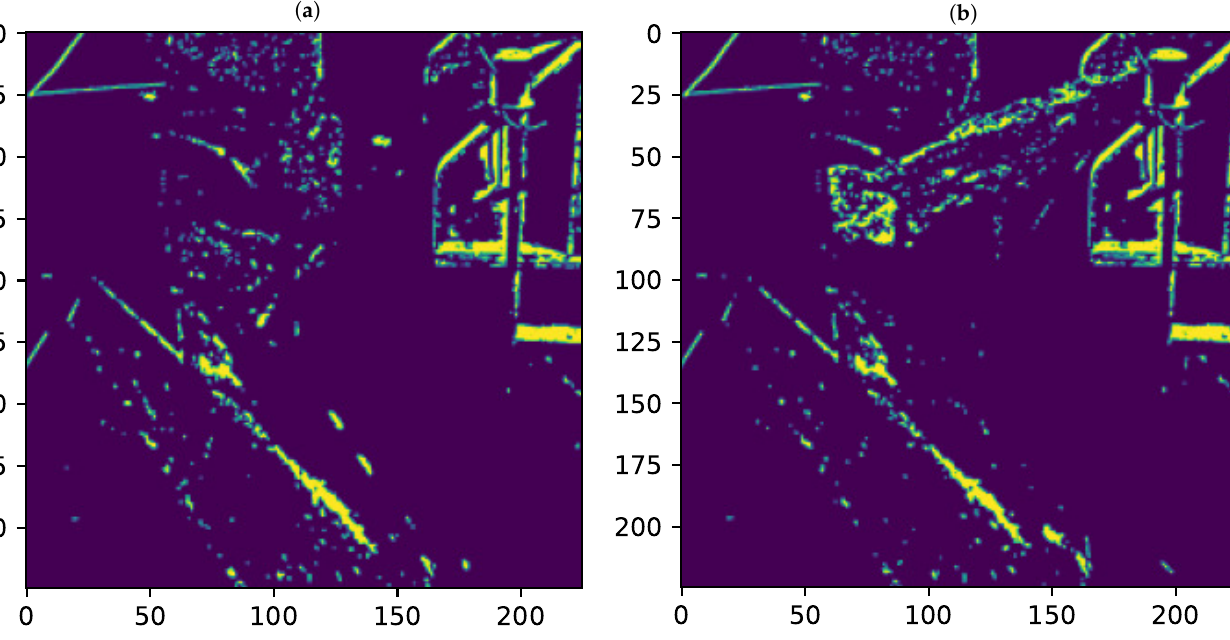
Figure 8. Morphology operators results: ( a ) normal condition; ( b ) blockage